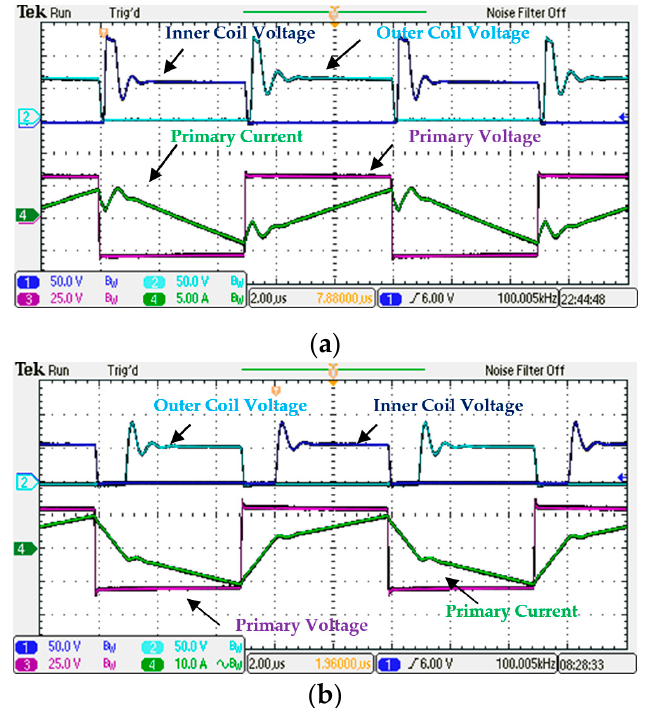
Figure 19. Current and voltage waveforms with 8 ferrite core bars: ( a ) under the 1 A load current and ( b ) under the 6 A load current.